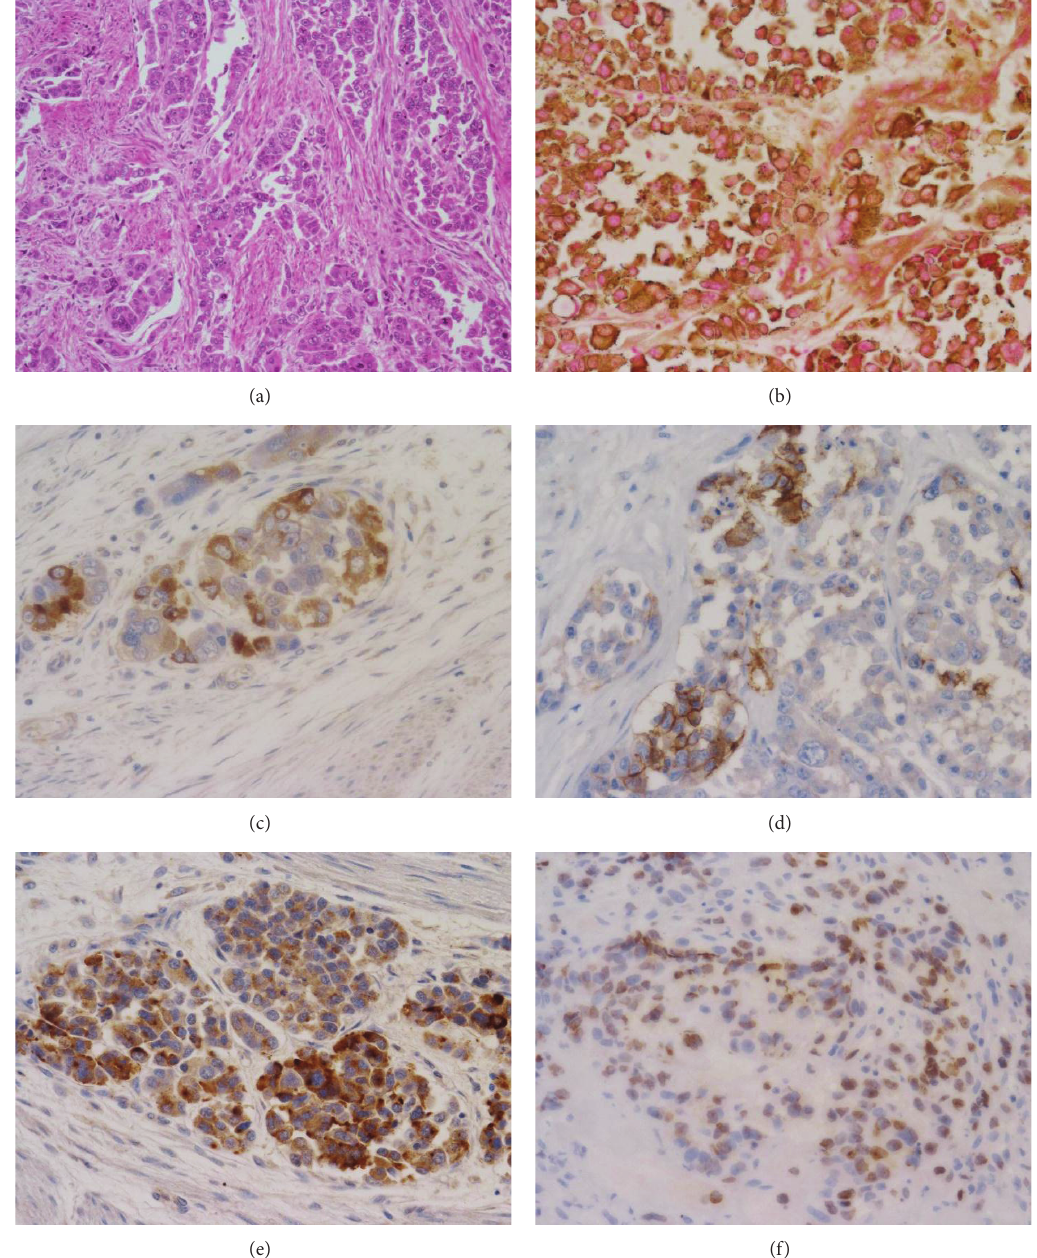
Figure 3: Histological features of the tumor cells. Grimelius and various immunohistochemical staining techniques were positive. (a) HE. (b) Grimelius. (c) Chromogranin A. (d) CD56. (e) IGF-II. (f)